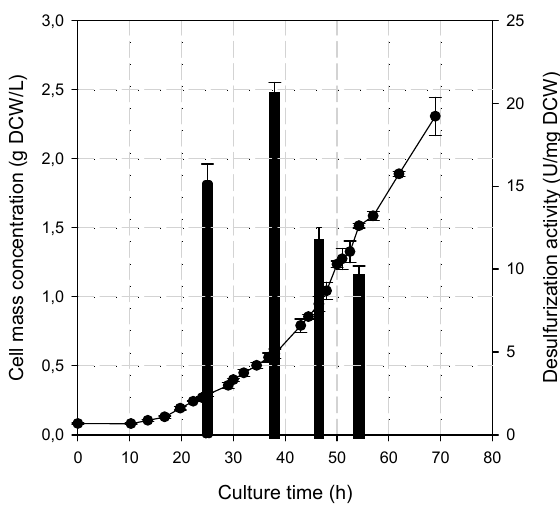
Figure 4. Evolution of cell mass concentration ( ◯ ) and biodesulfurization activity (CDA) ( ν ) of R. erythropolis ITGS8 during growth in a 20 L bioreactor.